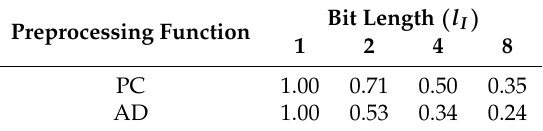
Table 2. Correlation coefficients of Equation (1) for preprocessing functions and the bit length of intermediate values [11,13].